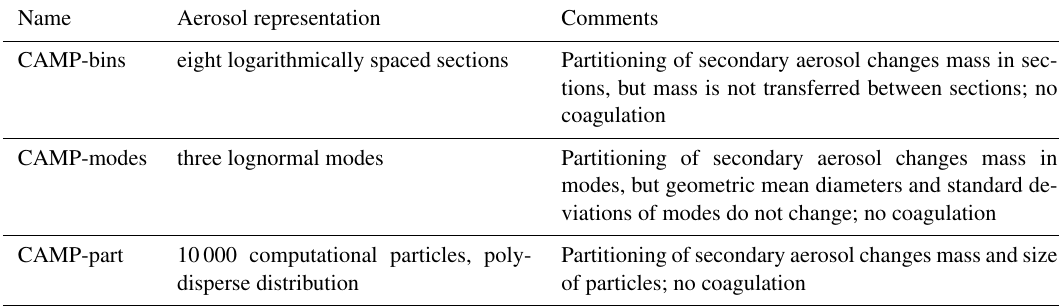
Table 8. Specification aerosol representation for the CAMP box model